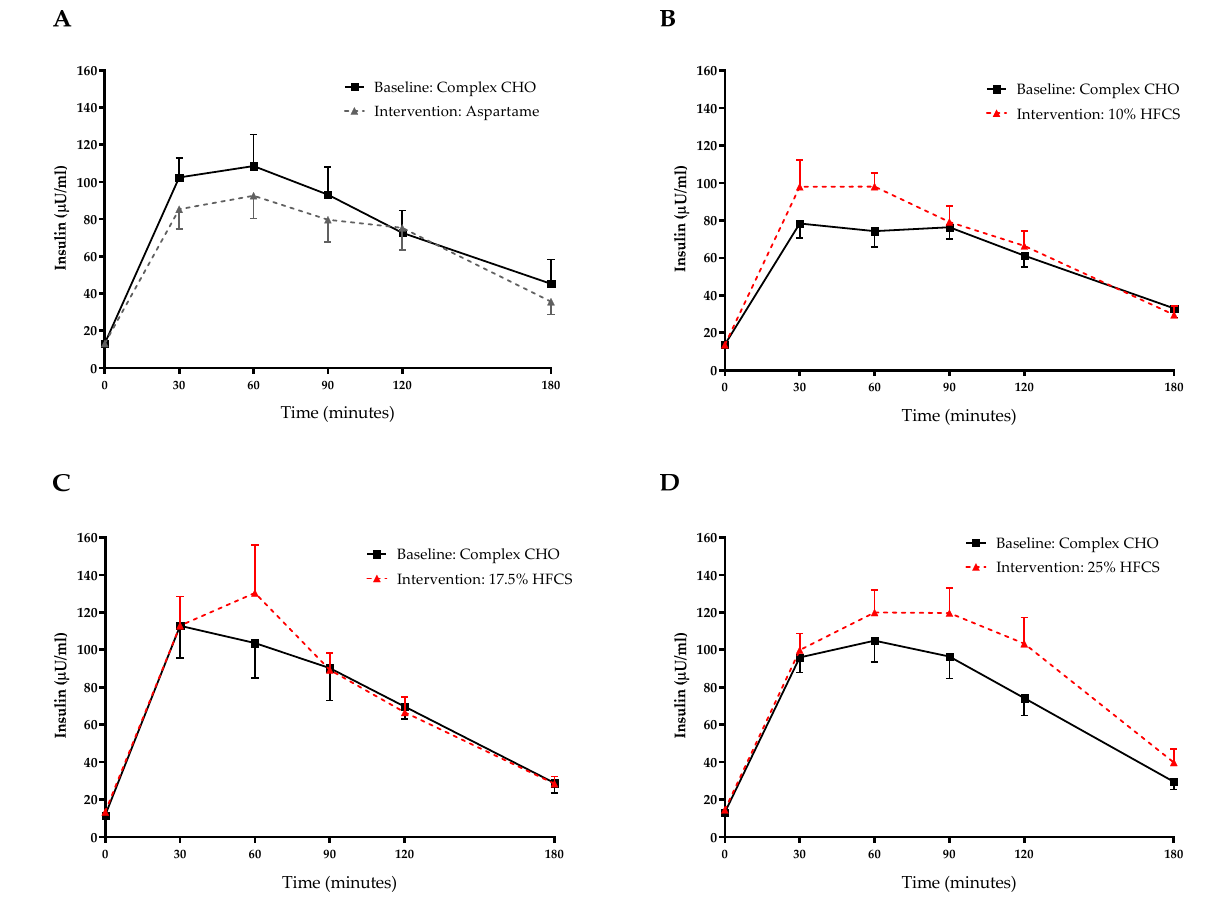
Figure 6. Plasma insulin excursions during 3-h OGTT: Insulin concentrations during OGTT at baseline and after consuming 0 ( n = 23) ( A ), 10 ( n = 18) ( B ), 17.5 ( n = 15) ( C ), or 25% ( n = 28) ( D ) HFCS-sweetened beverages for the two-week intervention.